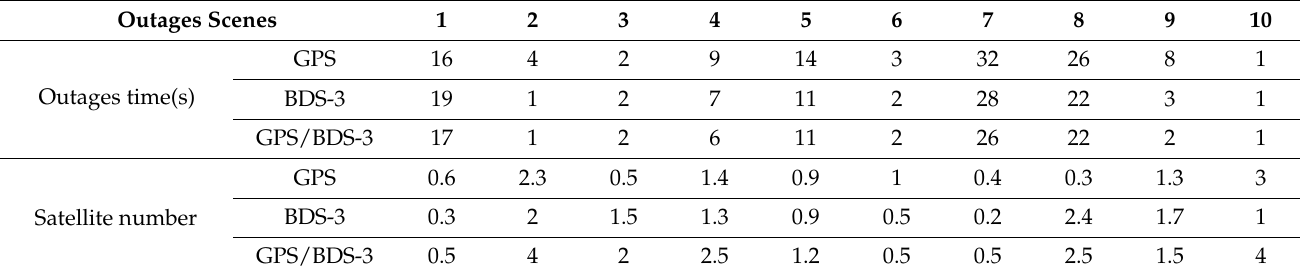
Figure 9. Satellite numbers and outages time between the 1500 s and 2500 s. Table 4. The number of available satellites and the GNSS outages